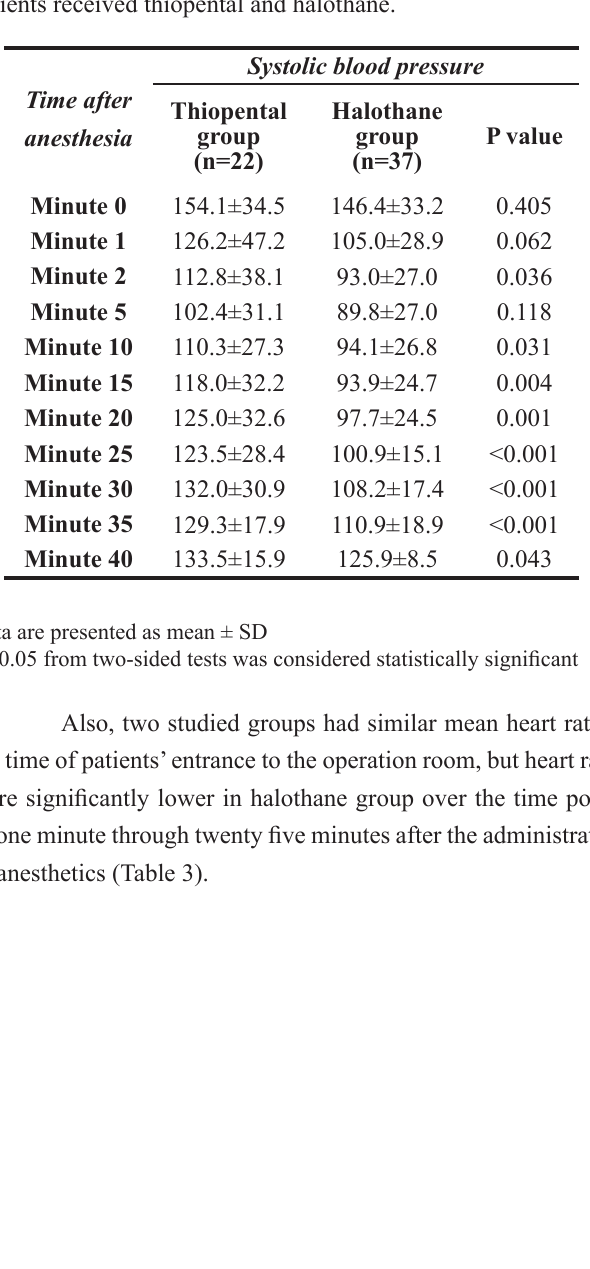
TABLE 2 - Comparison of blood pressure between the patients received thiopental and